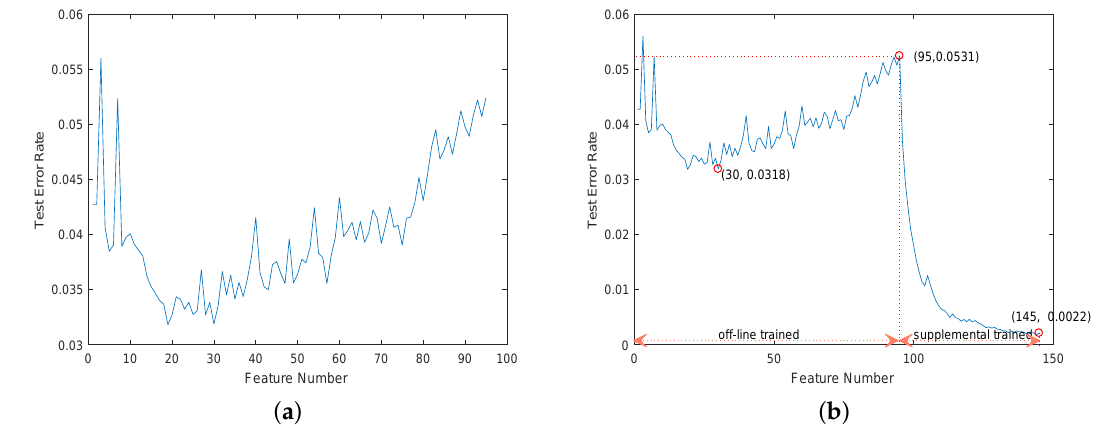
Figure 8. The curves of the feature number and the test error rate on circular sign detection. The curve in ( a ) is the performance of the off-line-trained AdaBoost-based detector. The curve in ( b ) is the performance of the supplemental trained AdaBoost-based detector. The three red circle markers in the curves denote the test error rates of the basic cascaded stages, the stage of supplemental training and the supplemental trained detector, respectively.